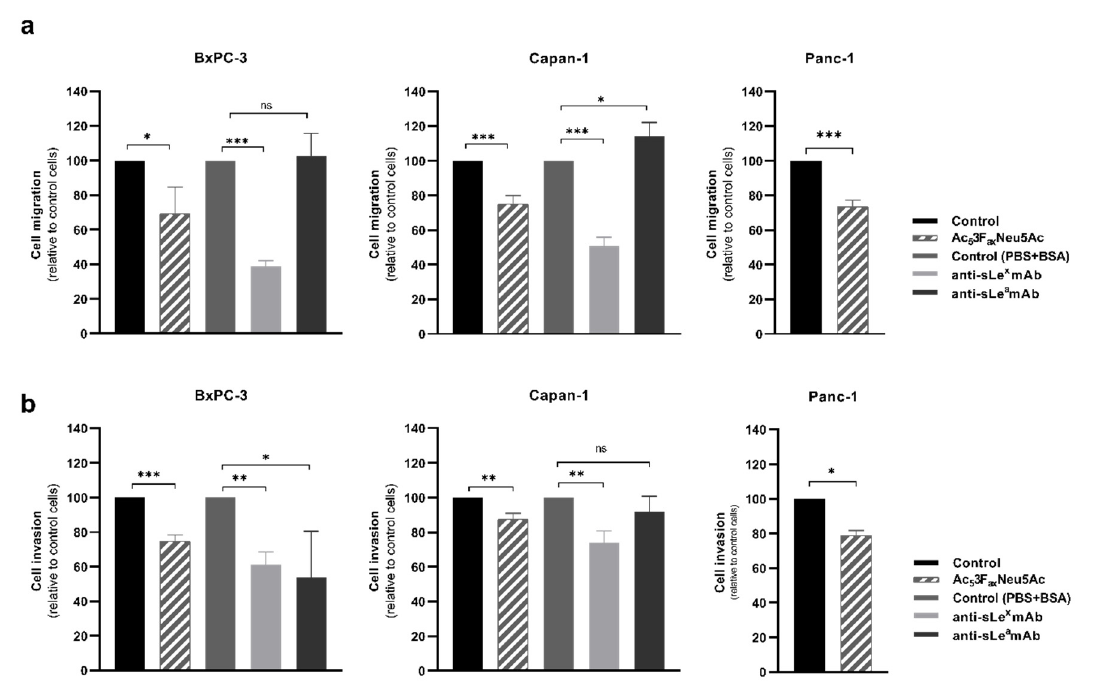
Figure 3. Ac 5 3F ax Neu5Ac treatment impaired cell migration (top) and invasion (bottom) of BxPC-3, Capan-1, and Panc-1 cells. BxPC-3 (left), Capan-1 (medium), and Panc-1 (right) cells were pre-treated for 72 h with ST inhibitor and allowed to ( a ) migrate through Collagen type-I coated transwells for 18 h for BxPC-3, 22 h for Capan-1, and 24 h for Panc-1 cells, or ( b ) invade in Matrigel-coated inserts for 24 h, 72 h, or 48 h for BxPC-3, Capan-1, and Panc-1, respectively. Migrated or invading cells were fixed, stained, and the area occupied by the cells was quantified with ImageJ software. Plots represent mean ± SD of migrated/invaded cells normalized to non-treated (control) cells from at least three independent experiments, * p < 0.05; **, p < 0.01 and ***, p < 0.001. ns: no significance.